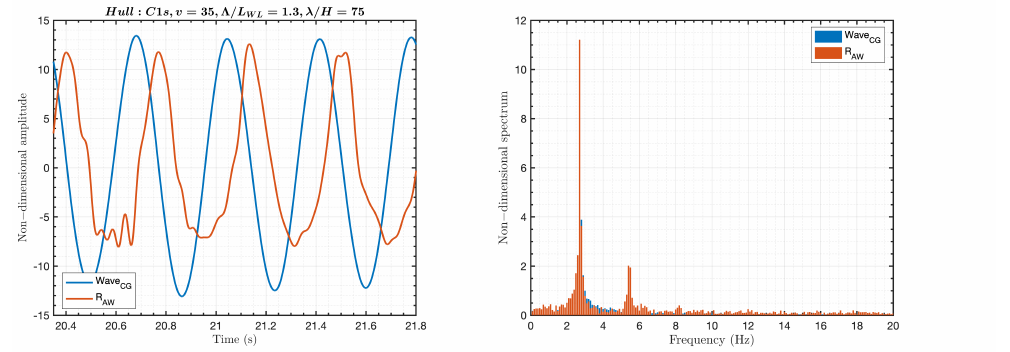
Figure 11. Example of added resistance time series and spectra. Added resistance nonlinear behavior is expected, as the hull pitches down toward an incoming wave and the bow sub vertical hull surfaces impact with the wave slope, large horizontal forces are suddenly generated (around t = 20.7 s on the left plot). The vertical hydrodynamic and restoring forces then counteract the pitching inertia and lifts the bow over the water leading to lower added resistance values until the next bow impact (t = 20.8–21 s). The sudden increase in added resistance occurs over a shorter time span with respect to the period of lower added resistance, and the peaks are higher amplitude than troughs. This occurs as the hull motion resulting from the impact allows the sub vertical surfaces to be over the water until the next bow impact, allowing for a longer period of lower